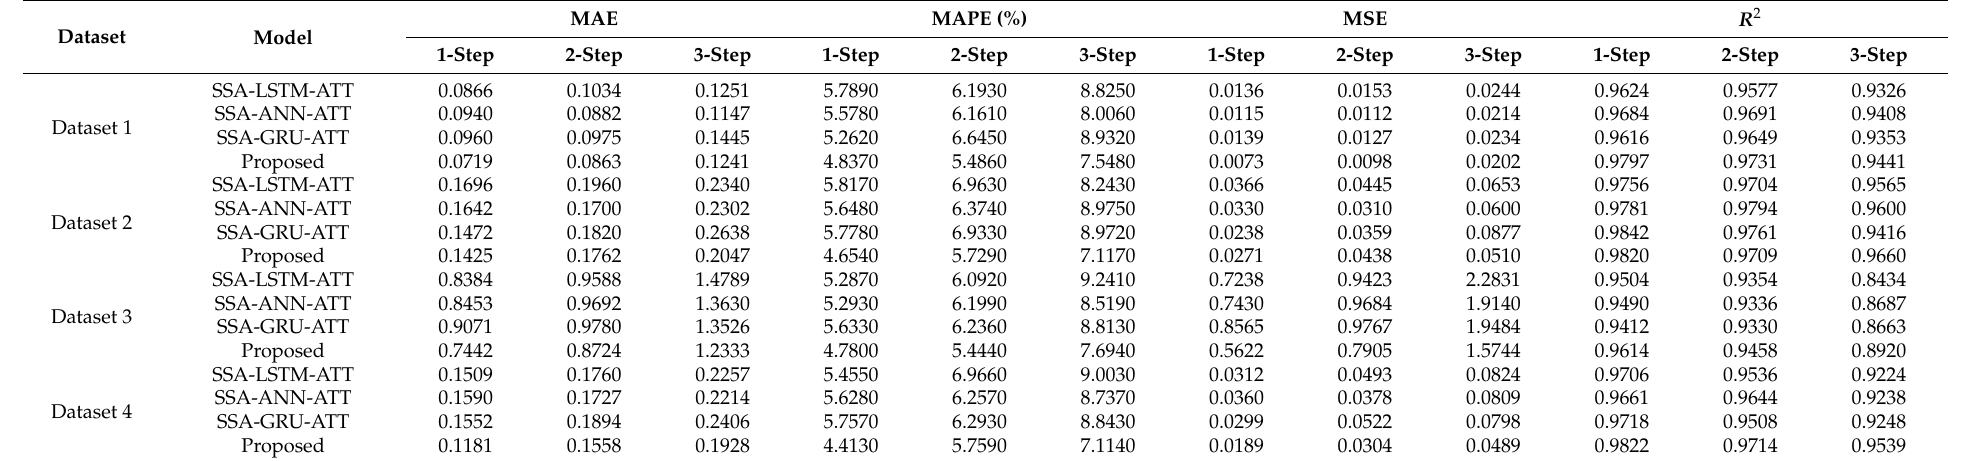
Table 5. Error evaluation results of models with different feature selection methods in four datasets.